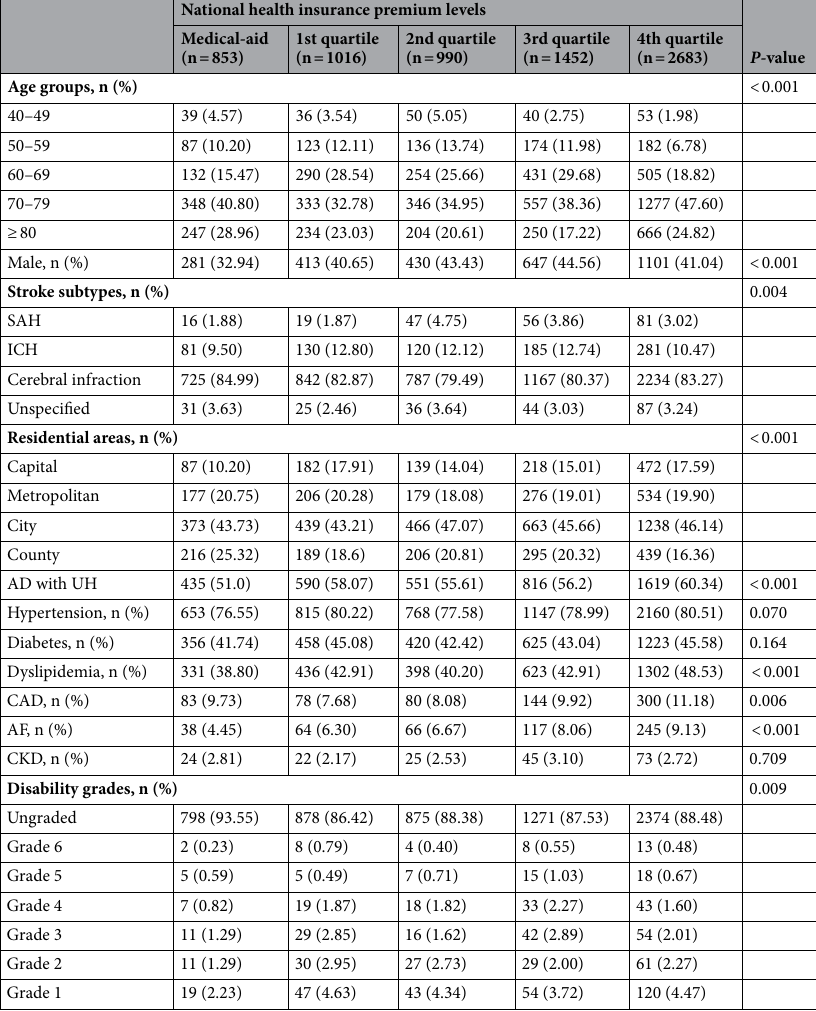
Table 1. Baseline characteristics according to the NHIP levels. SAH subarachnoid hemorrhage, ICH intracranial hemorrhage, AD administrative districts, UH university hospital, CAD coronary artery disease, AF atrial flutter/fibrillation, CKD chronic kidney